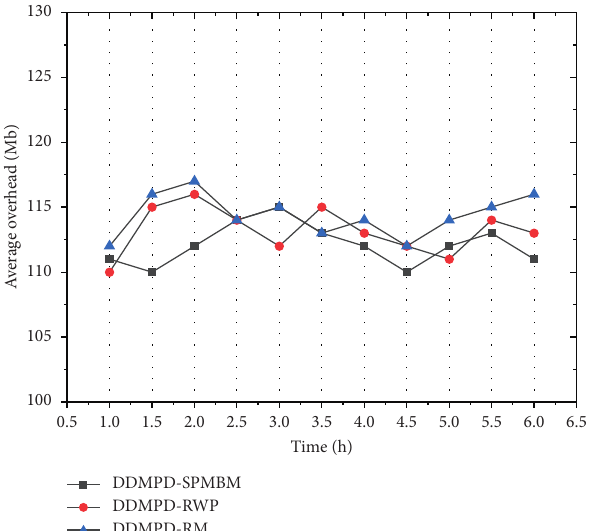
Figure 18: Relationship between energy consumption and time in three mobile models.